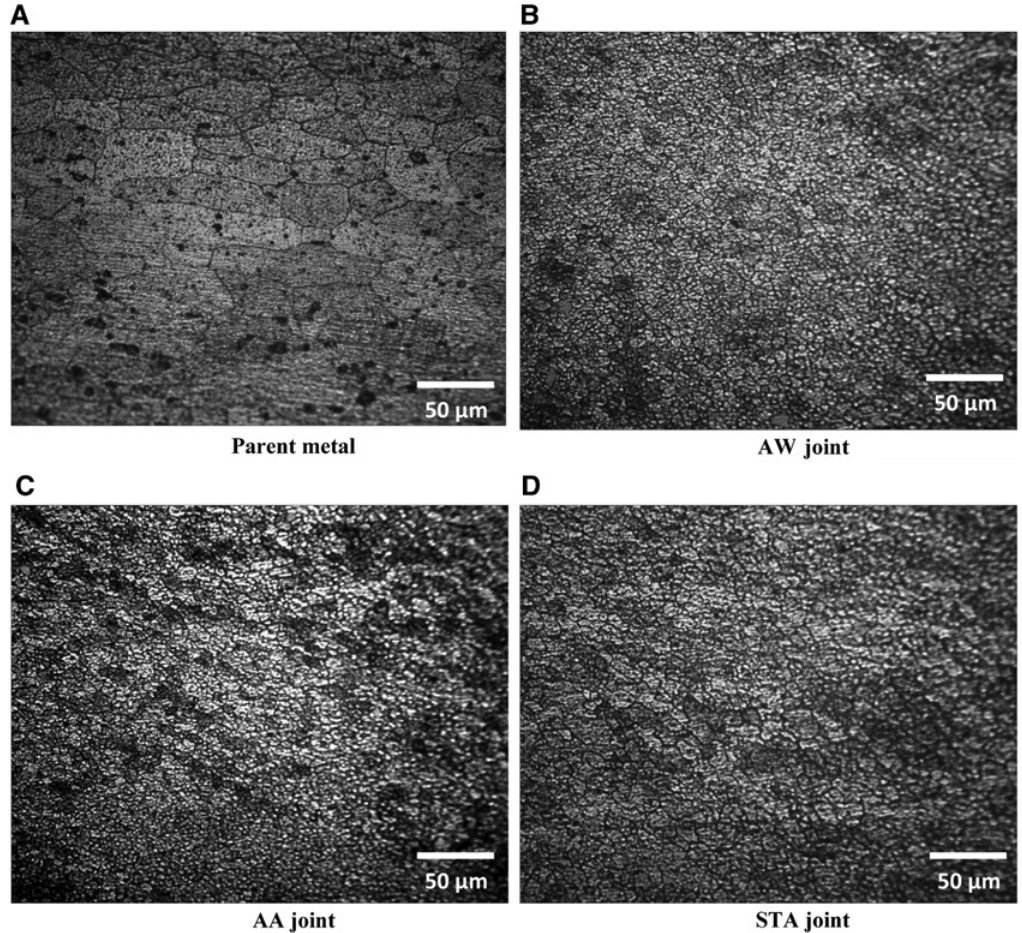
Figure 4: Optical micrograph of the parent metal and stir